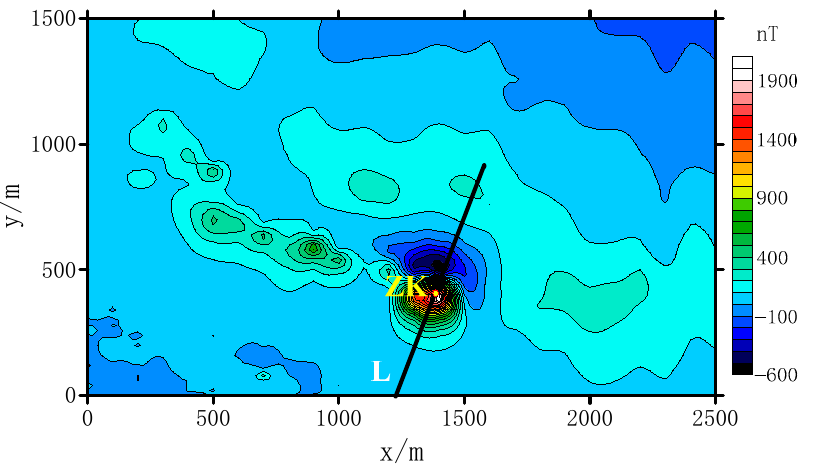
Figure 14. The magnetic contour map of ∆ T in the Zaohuoxi area. (ZK is the borehole position and L is the survey line).